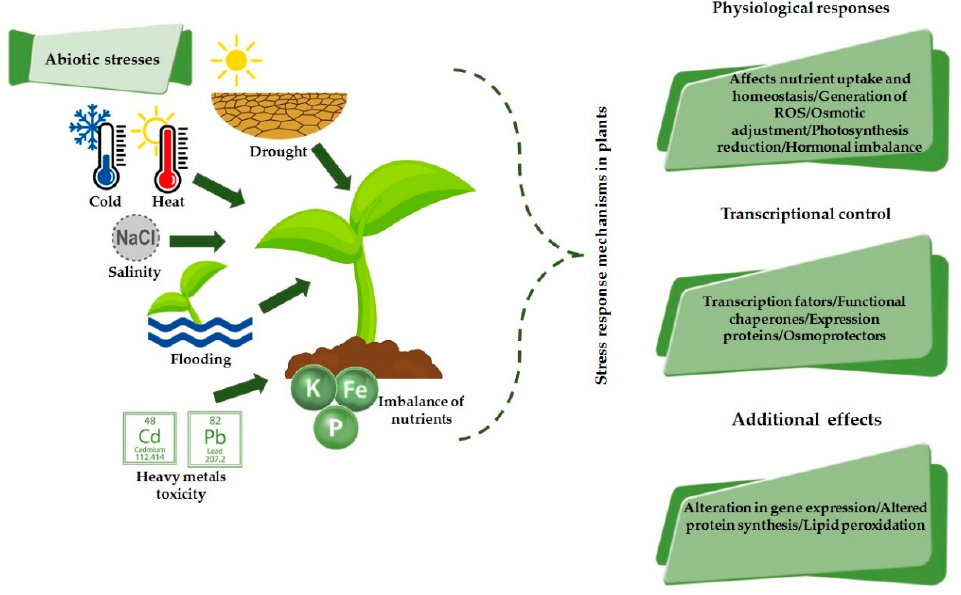
Figure 1. Plant response cascade to different abiotic stresses.